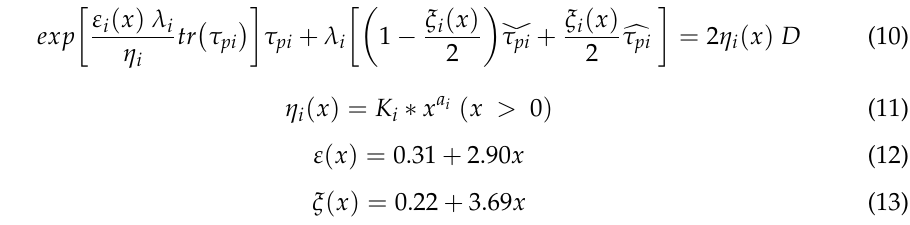
Figure 6. The dependence of ε ( a ) and ξ ( b ) on the filler volumetric content x . The red lines are fitted based on the PTT model (Table 1). The associated equations are presented in each subplot.